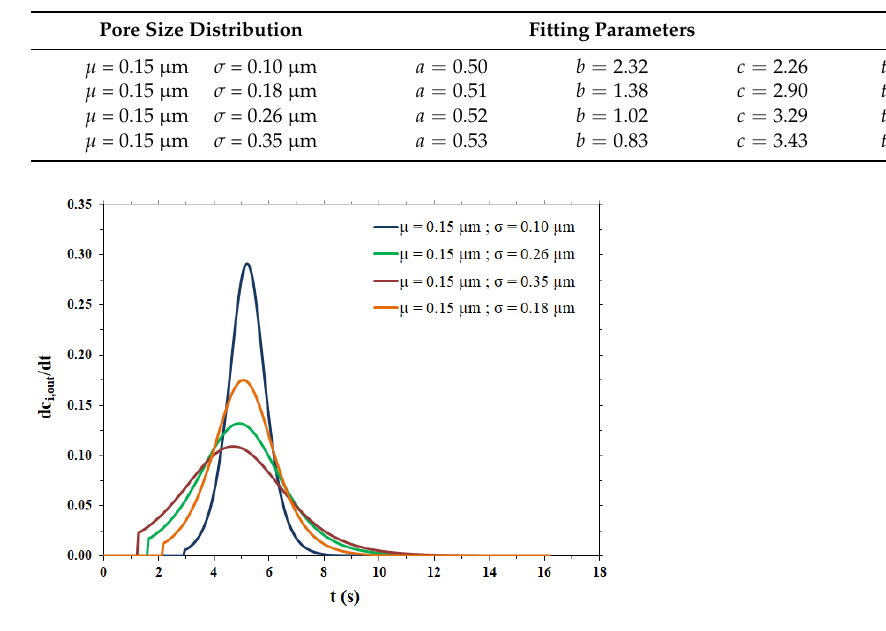
Table 4. Fitting parameters of the breakthrough curves in Figure 4b.